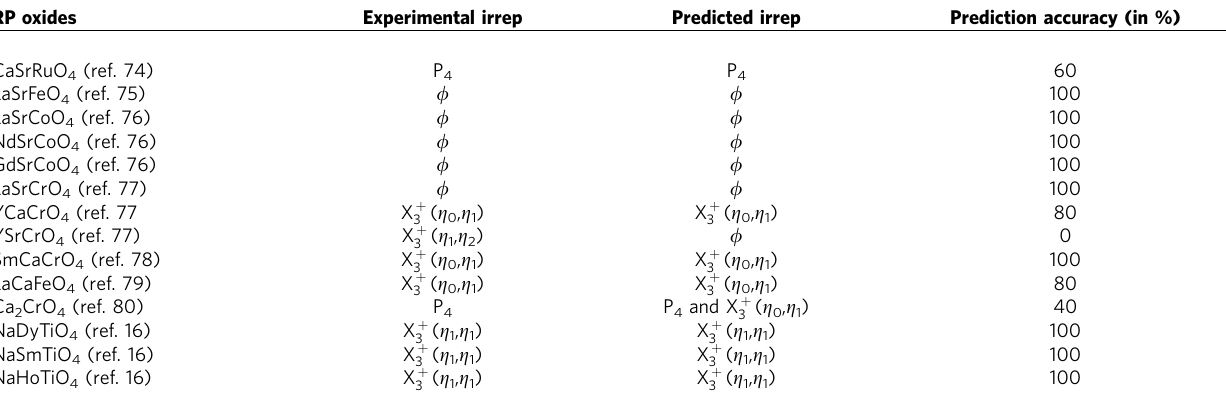
Table 2 | A comparison between experimental and predicted irreps to independently validate the classification models. RP